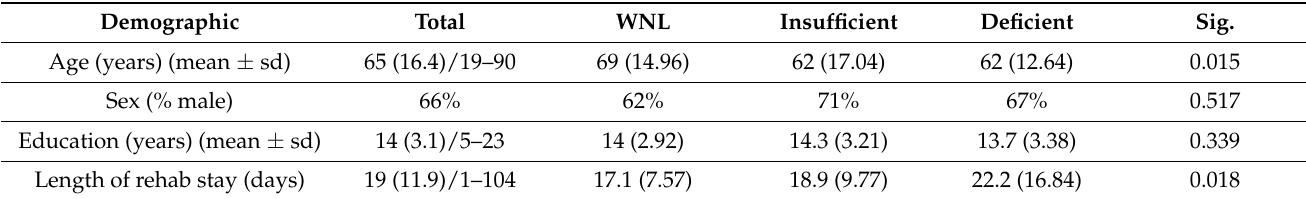
Table 1. Demographic variables and length of rehab stay by vitamin D status.